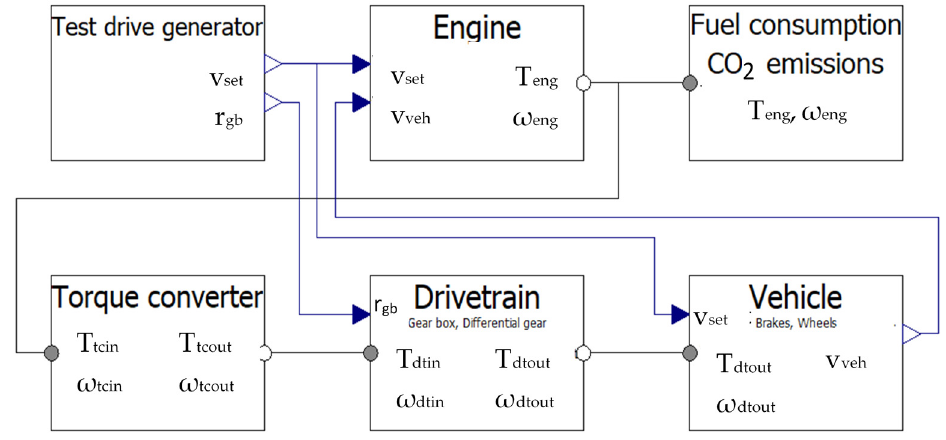
Figure 1. General diagram of the developed driving test simulation for the 2018 Toyota Camry LE vehicle.